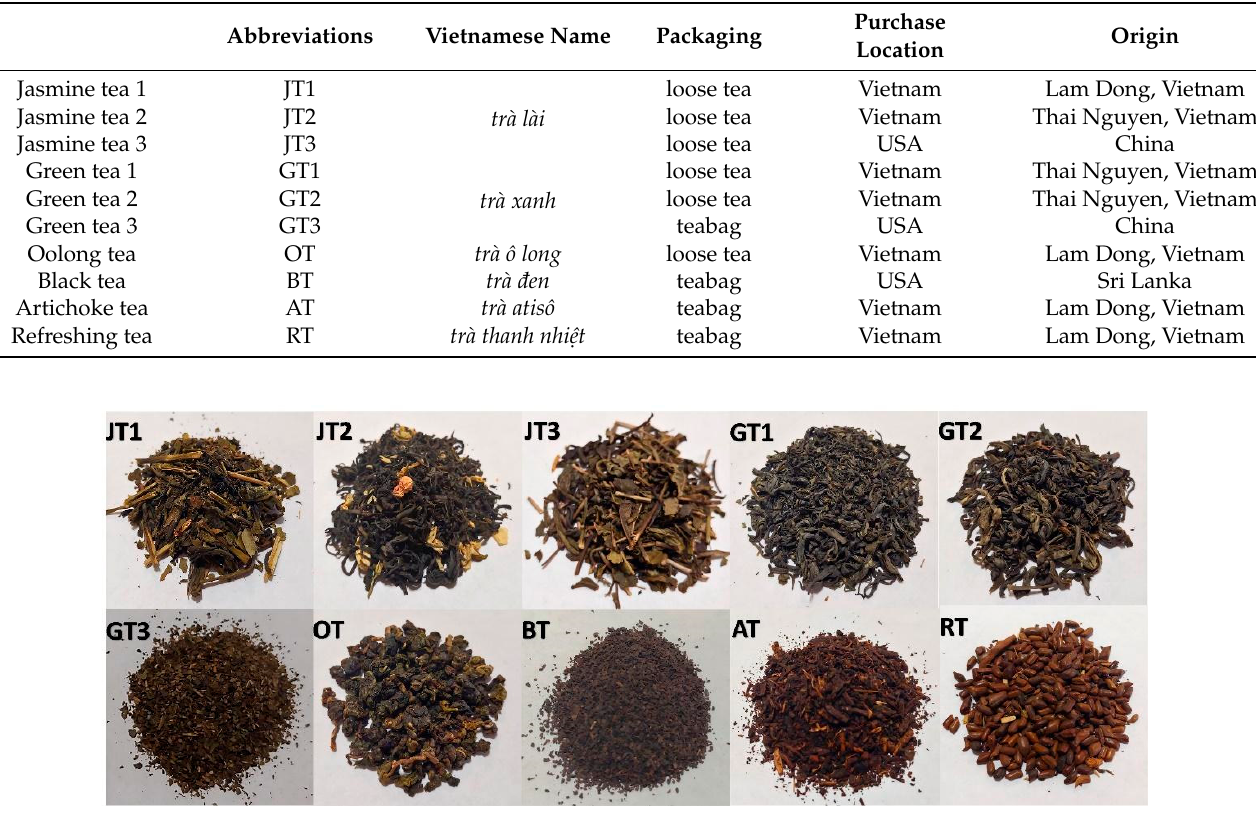
Figure 1. The tea and herbal tea samples used in the study.